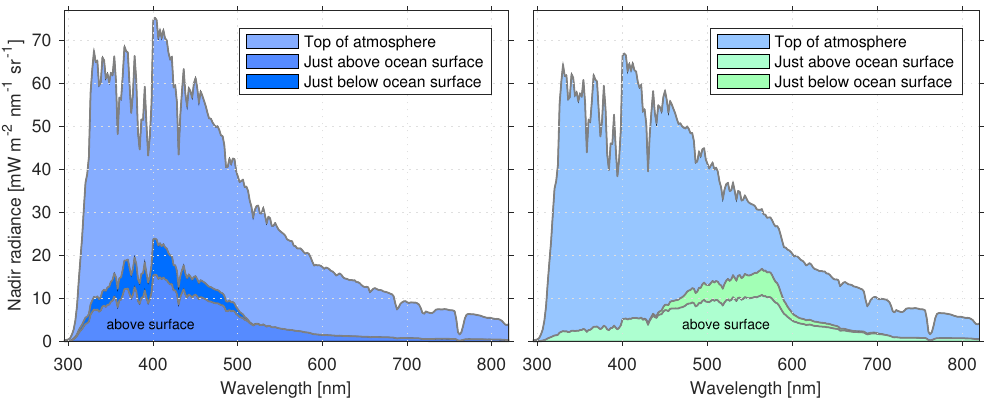
m − 3 , MIN = 0.003 g m − 3 , · ·